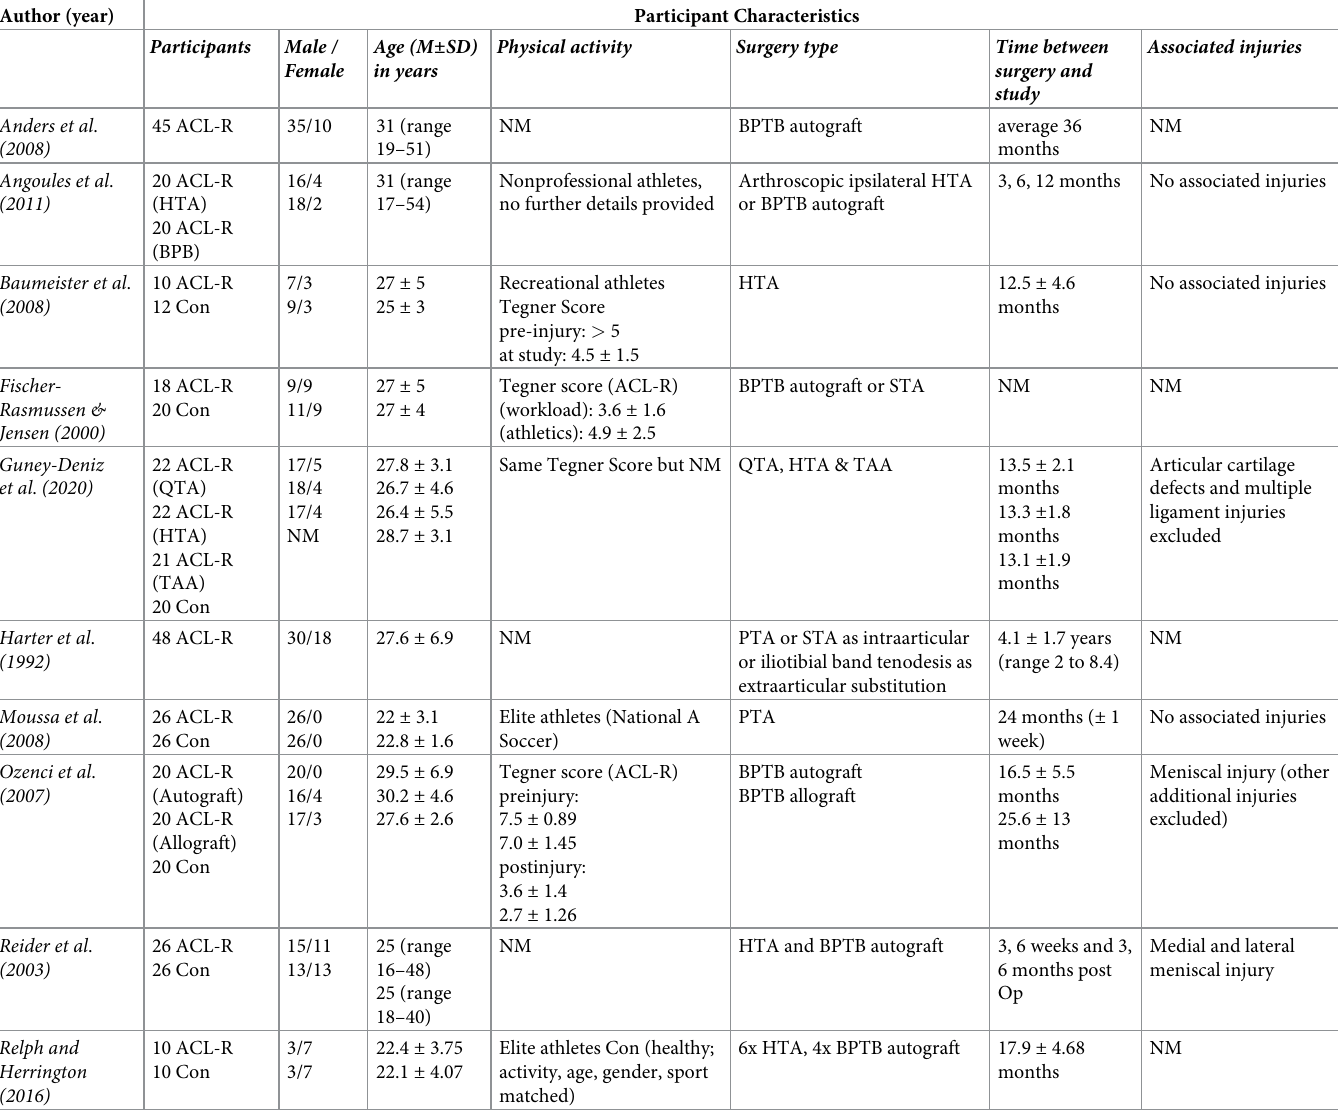
Table 1. Participant characteristics of the included